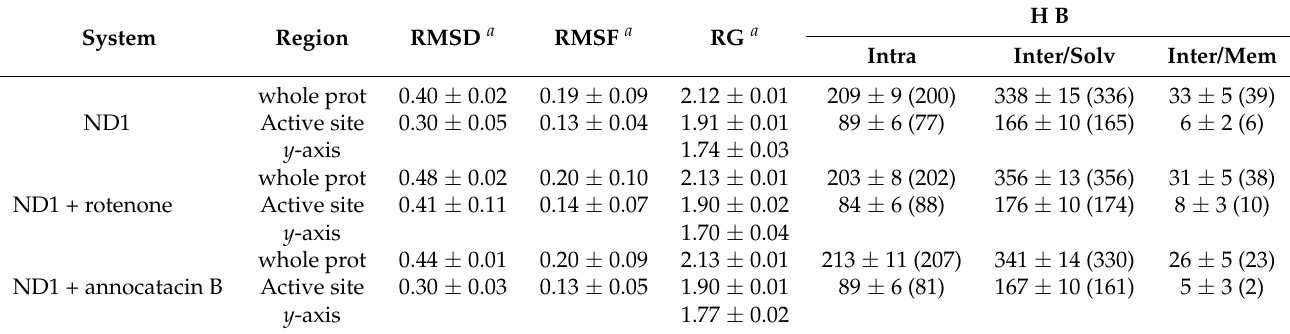
Table 3. Stability Descriptors of the ND1